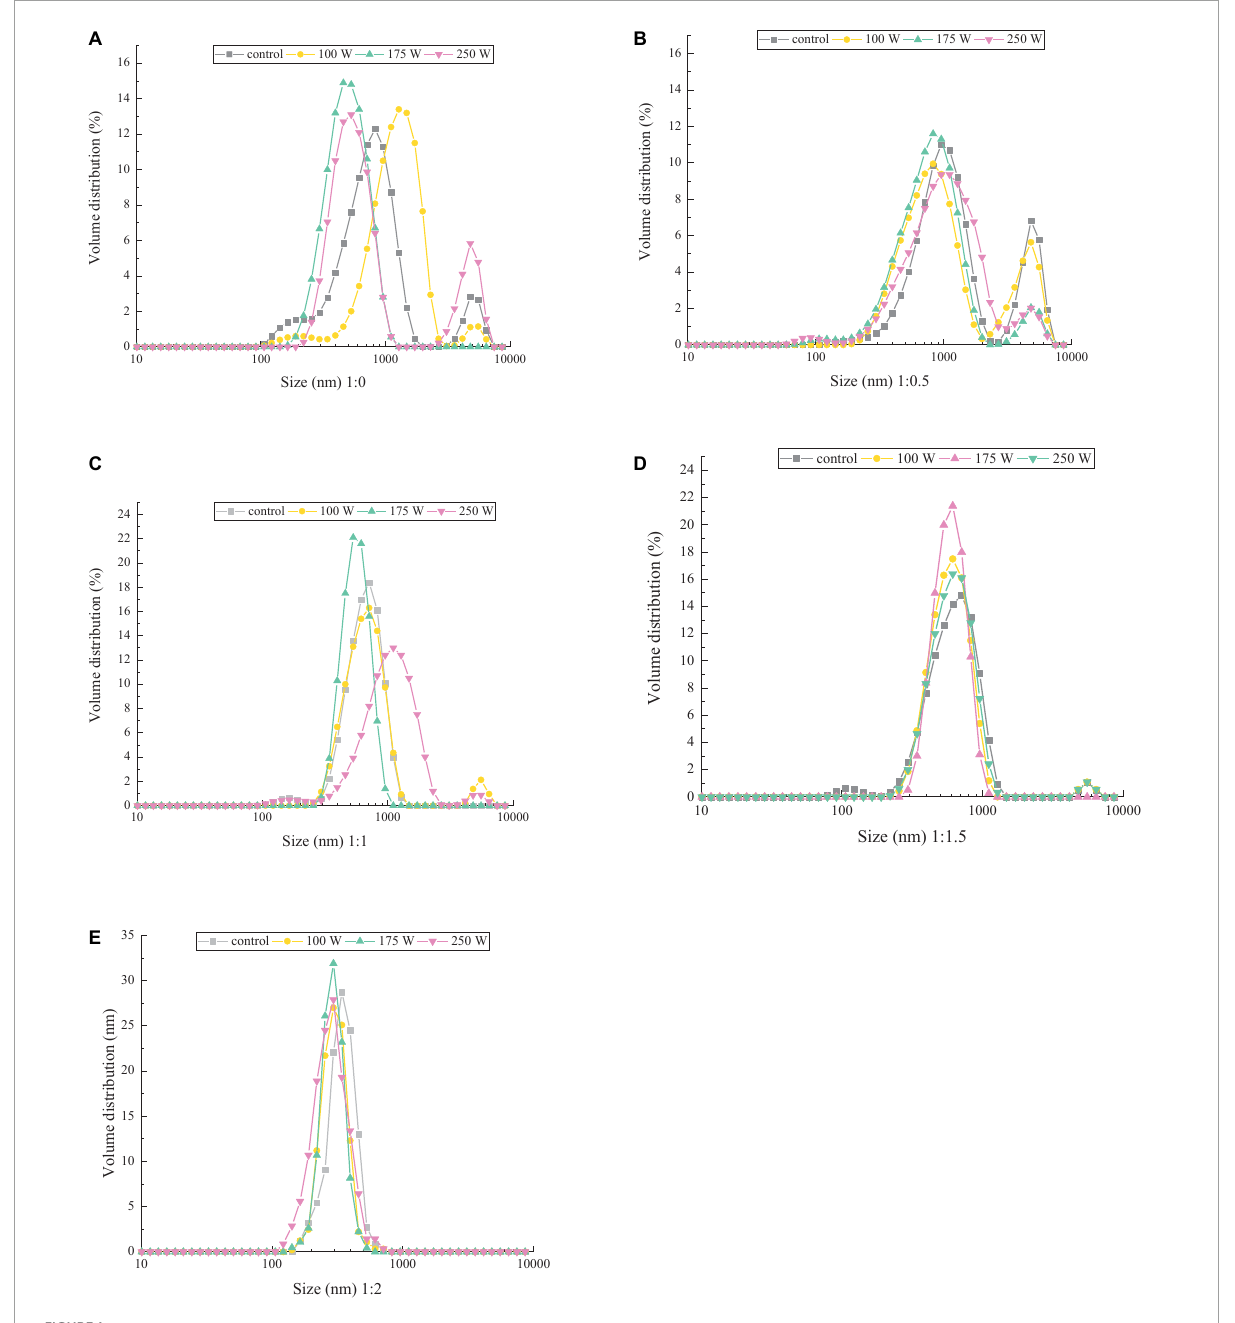
FIGURE1 Effect of ultrasonic power on the particle size distribution of microcapsules with different ratios of OB–MD: (A) OBs, (B) OB-MD 0.5, (C) OB-MD 1, (D) OB-MD 1.5, and (E) OB-MD 2.